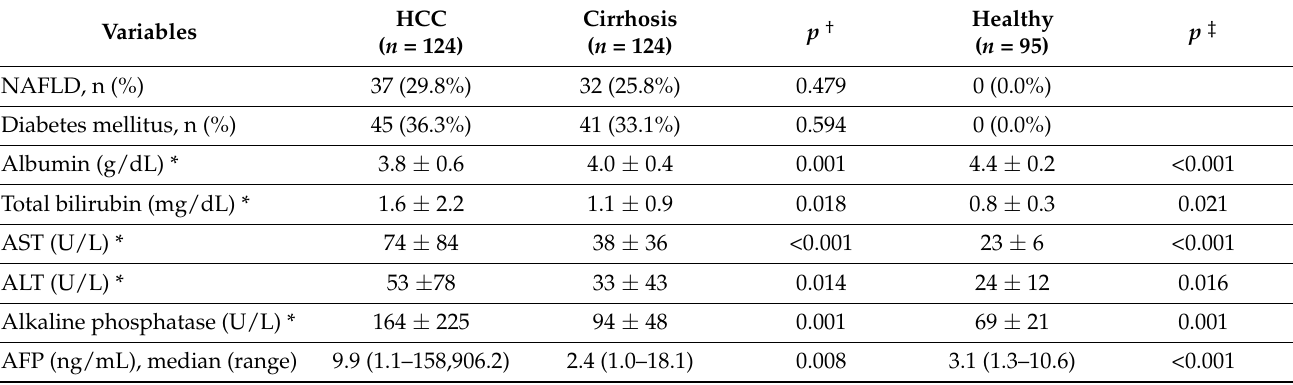
Table 1. Baseline characteristics of the study Table 1. Cont.